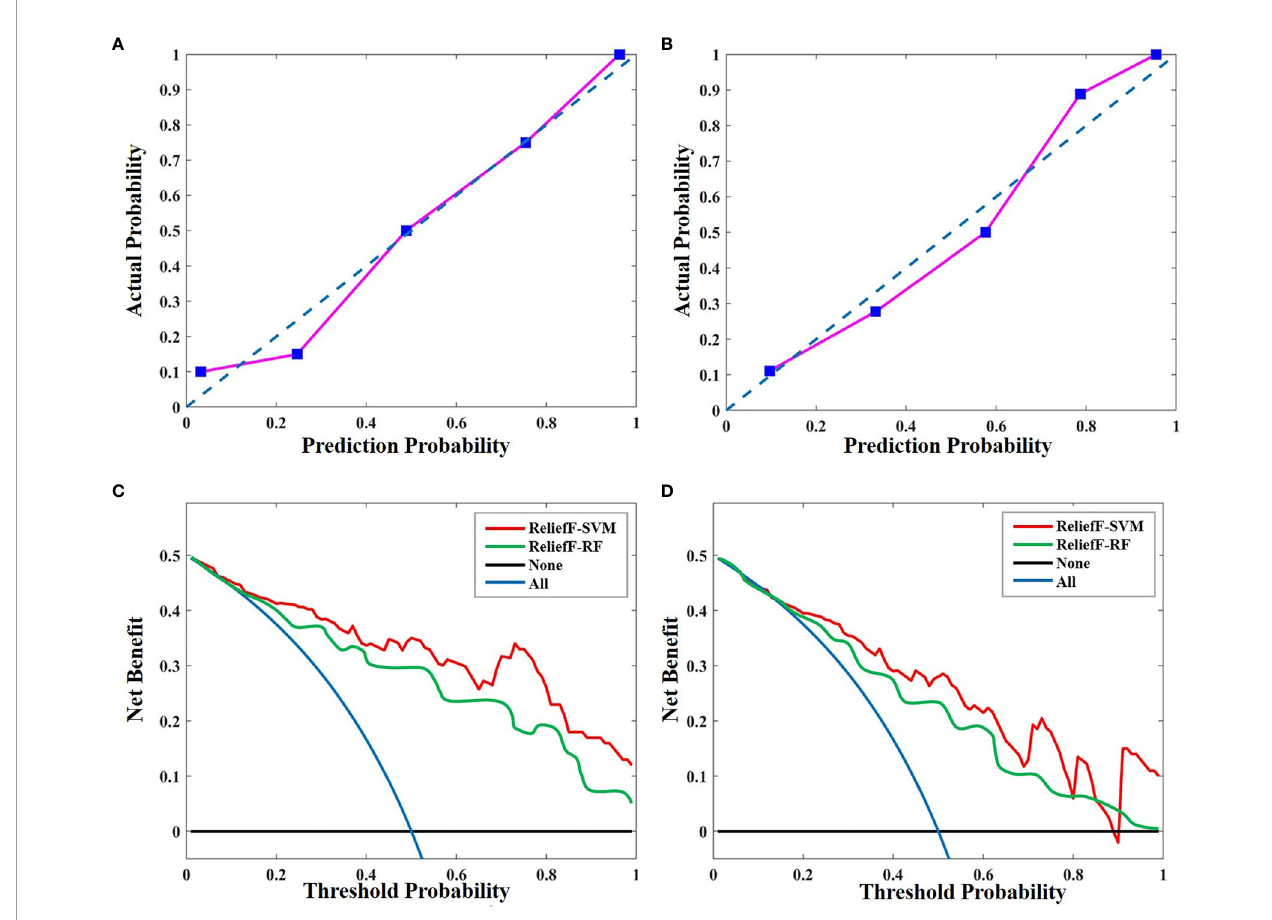
FIGURE 6 | Calibration curves of the radiomics model in (A) the primary and (B) validation cohorts. Calibration curves depict the calibration of ReliefF-SVM model in terms of the agreement between the predicted probability and actual outcomes. The y -axis represents the actual rate of HIFU probability. The x -axis represents the predicted probability. The diagonal blue line represents a perfect prediction by an ideal model. The pink line represents the performance of the radiomics model, where a closer fi t to the diagonal blue line represents a better prediction. Decision curve analysis for the ReliefF-SVM and ReliefF-RF models in (C) the primary and (D) validation cohorts. The y -axis measures the net bene fi t. The red and green lines represent the radiomics model. The blue line represents the assumption that all patients received high HIFU ablation. The black line represents the assumption that no patients received high HIFU